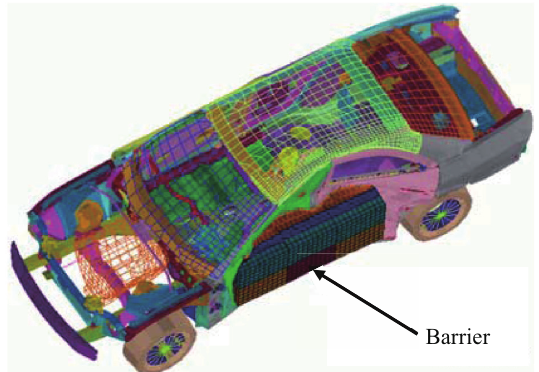
Figure 10. Finite element model utilized in the car side impact problem [1].